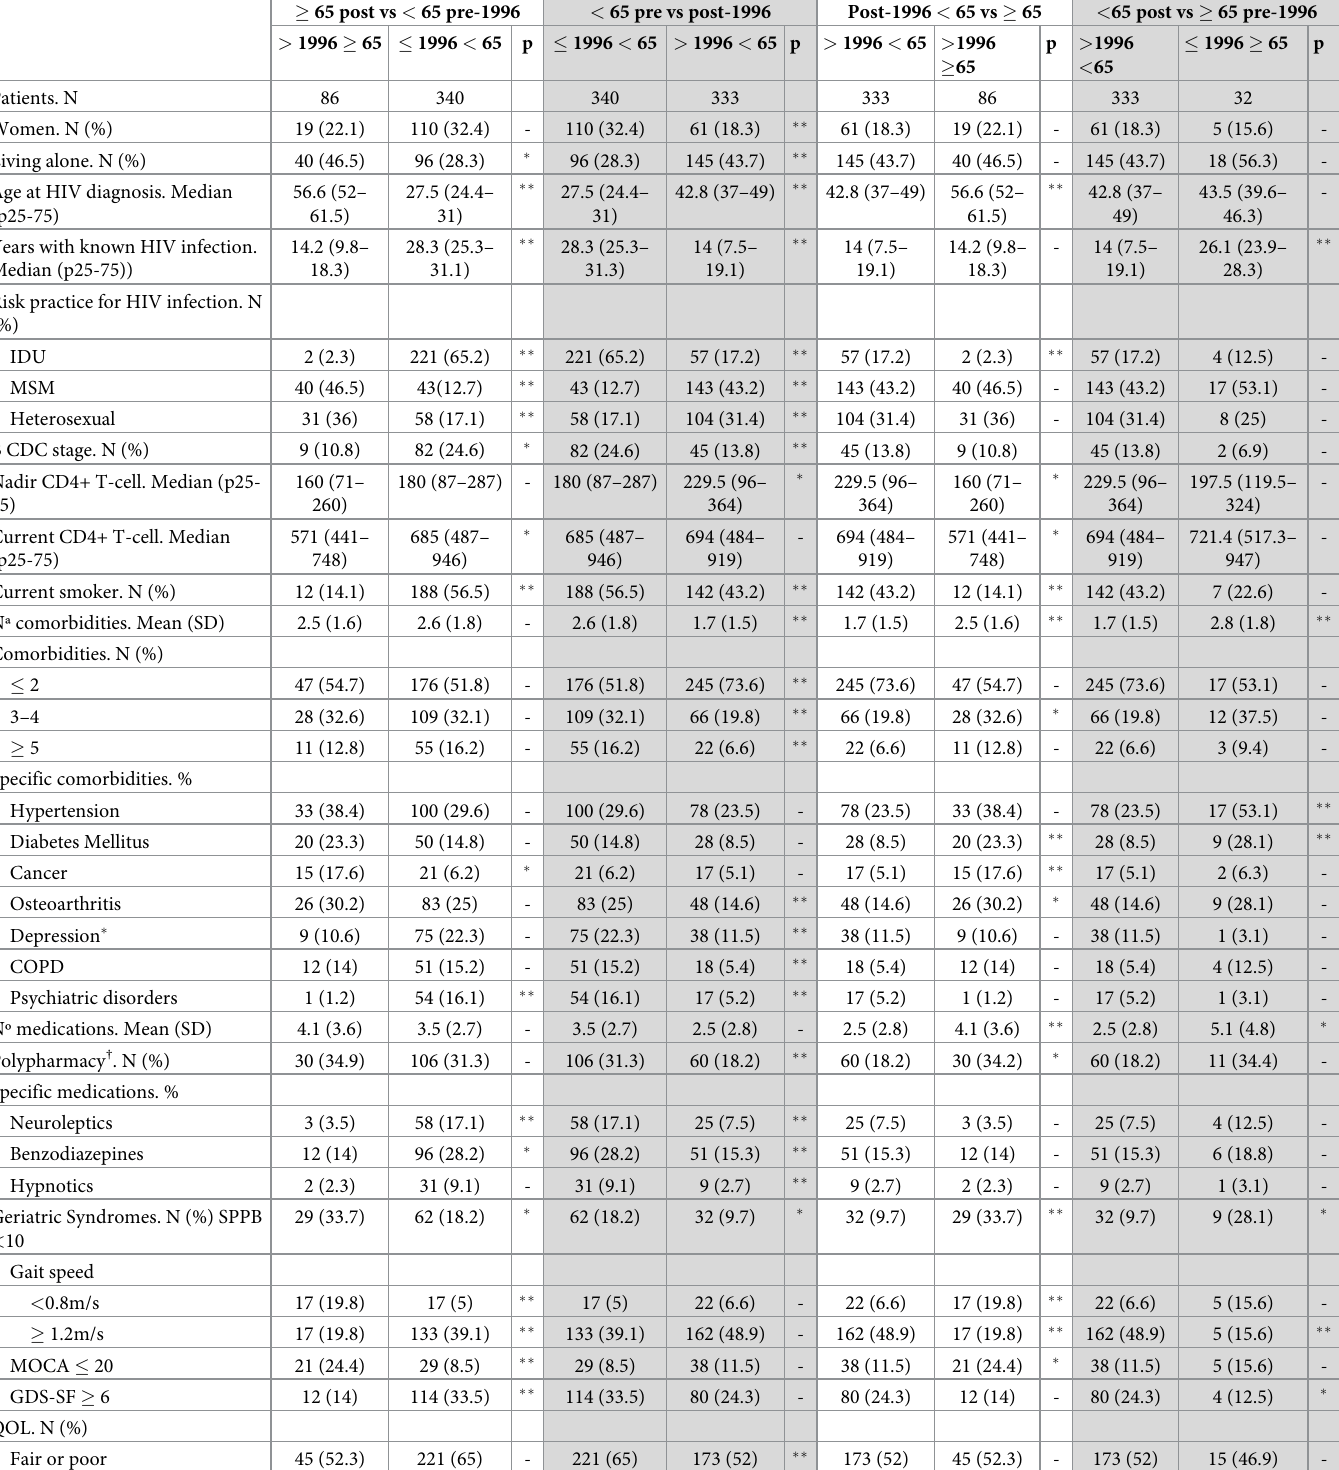
Table 2. Comparison by groups combining chronological age and year of HIV